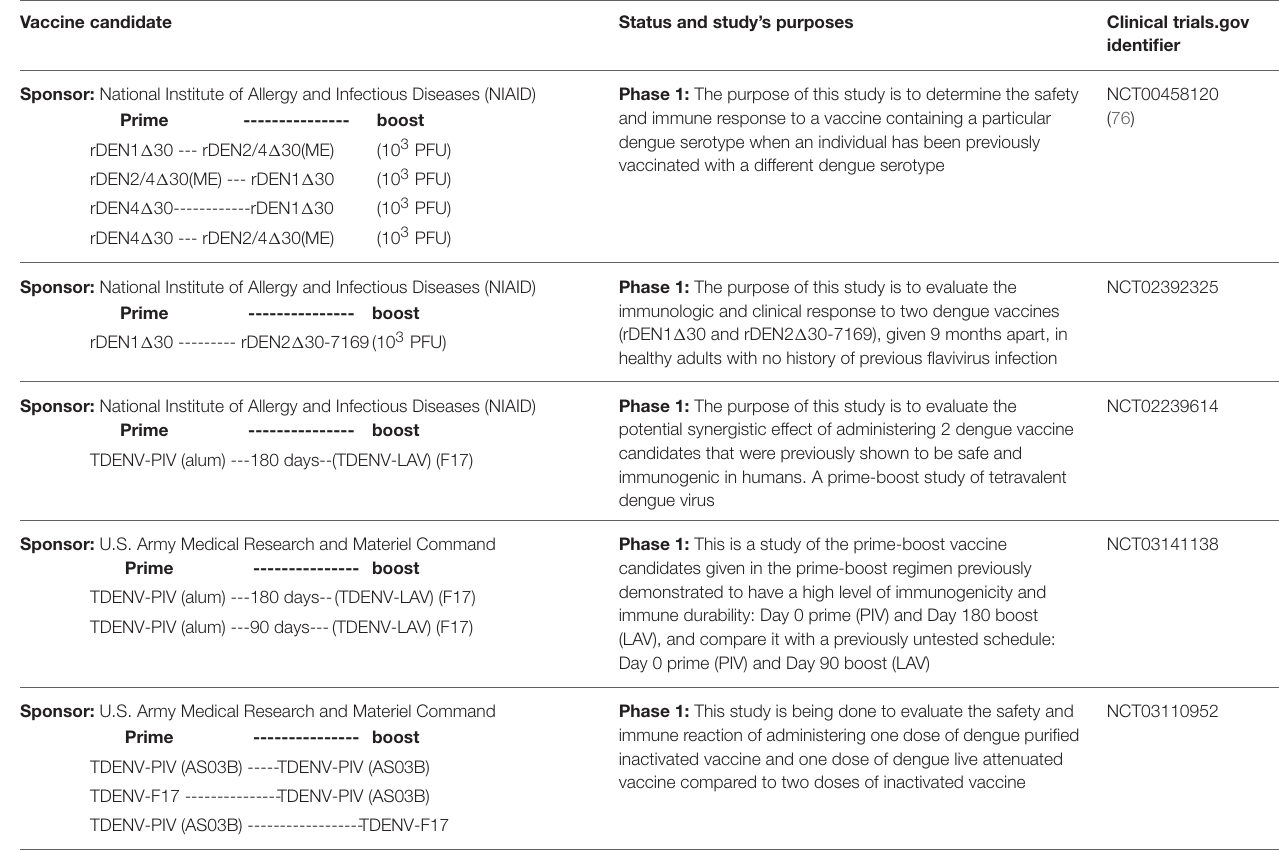
TABLE 2 | Posted clinical trials evaluating Dengue vaccine candidates in a prime-boost regime. Vaccine candidate Status and study’s purposes Clinical trials.gov